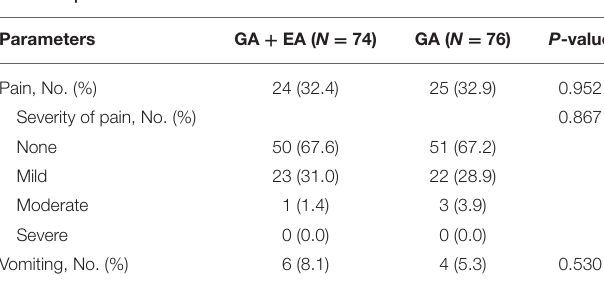
TABLE 2 | Adverse